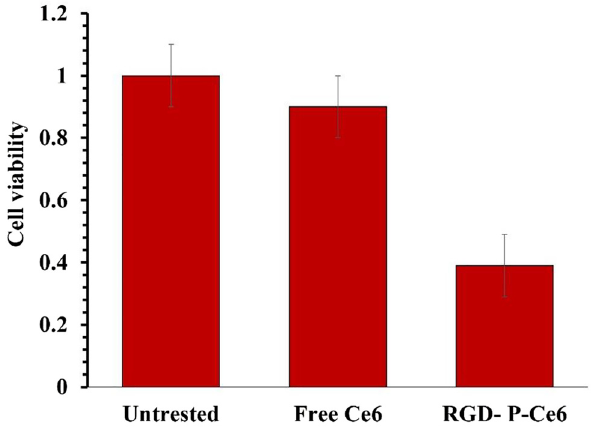
Figure 14: A375 Cell viability after PDT treatment (660 nm, 3.5 mW cm − 2 , 30 min). Adapted from Yuan et al.